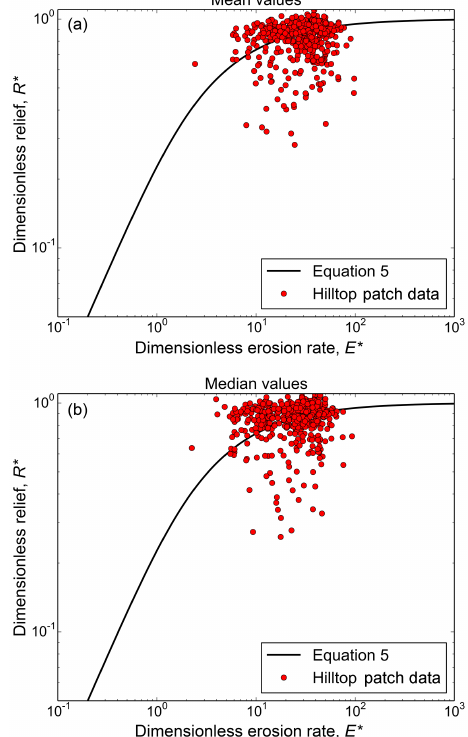
Figure 8. Comparison between hilltop patch values generated using a spatial mean (a) and a spatial median (b) for the Oregon Coast